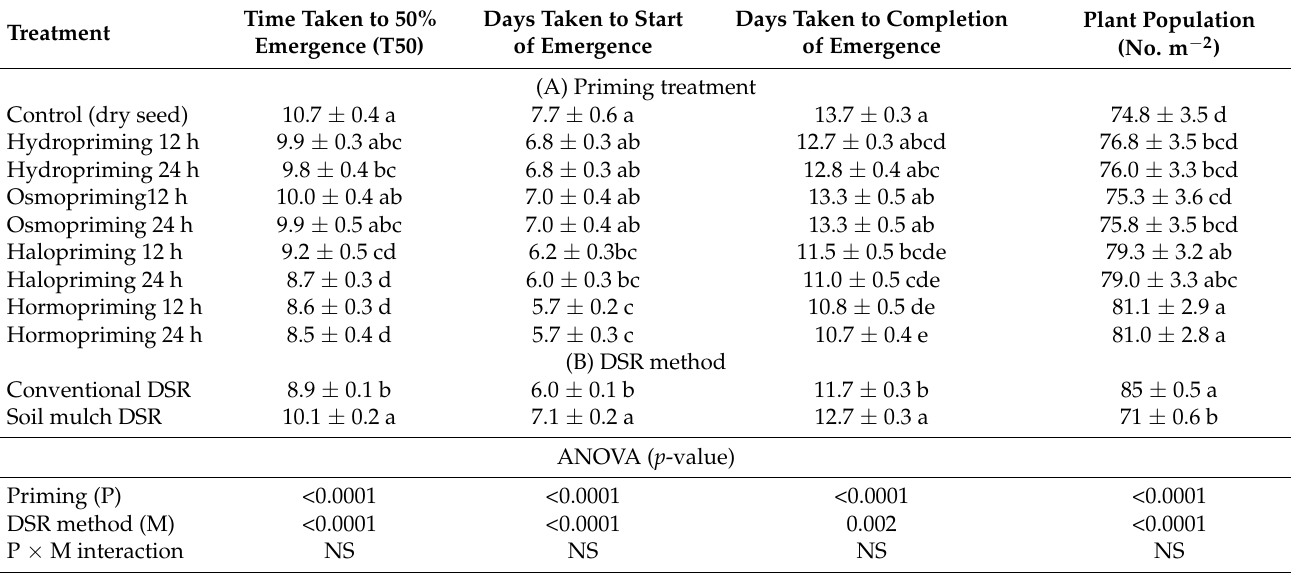
Table 3. Time taken to 50% emergence (T50), days taken to start and completion of emergence, and final plant population as affected by different seed priming and DSR establishment methods during 2019 at Ludhiana, India.